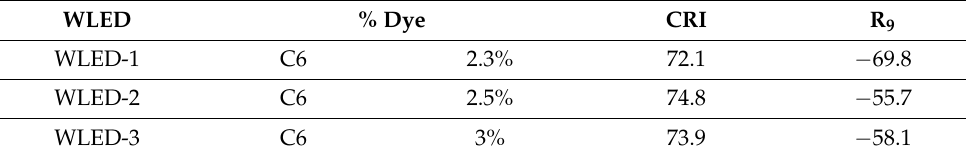
Table 1. Description of the WLEDs (1, 2, and 3) and optical properties. WLED %